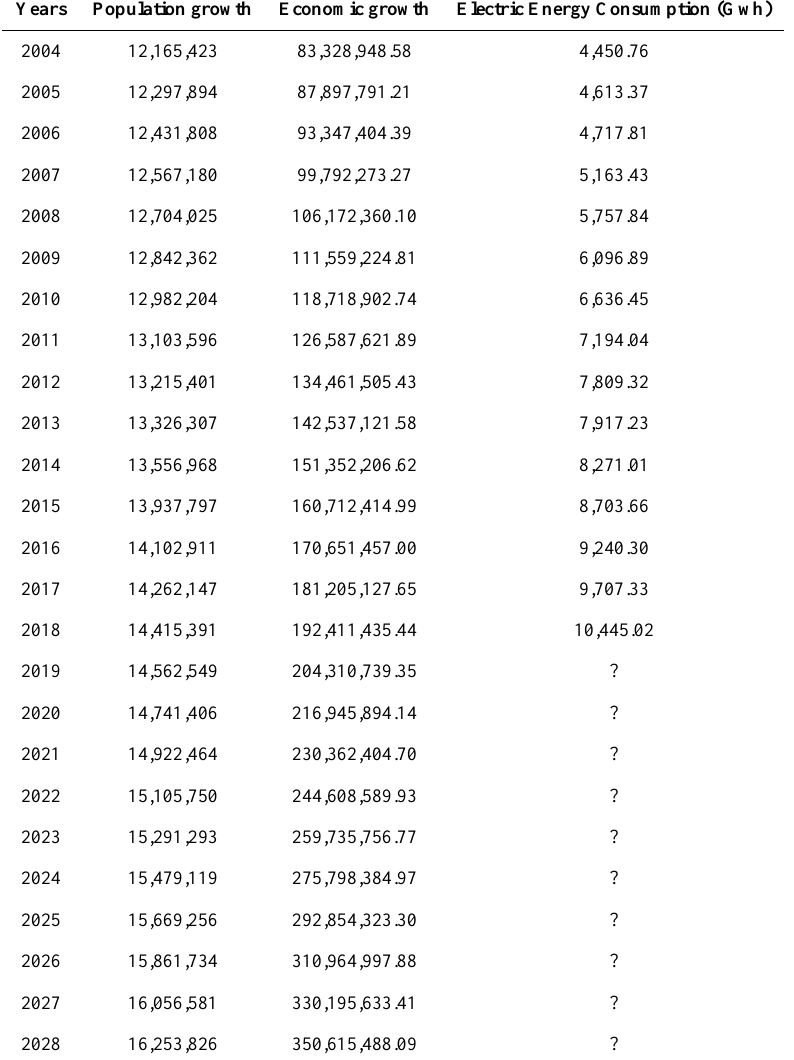
Table 6. Forecast of electricity